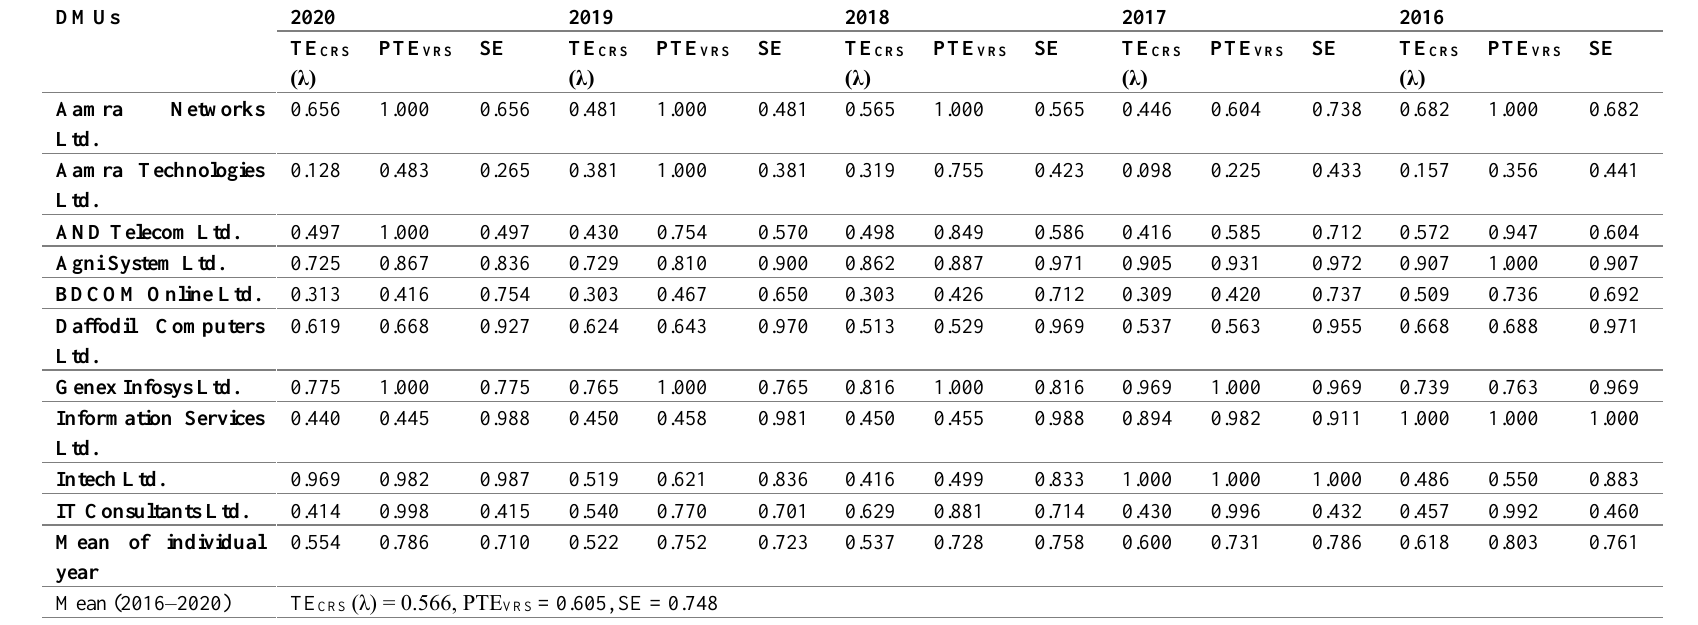
Table 4: DEA Estimations – Input Oriented Technical